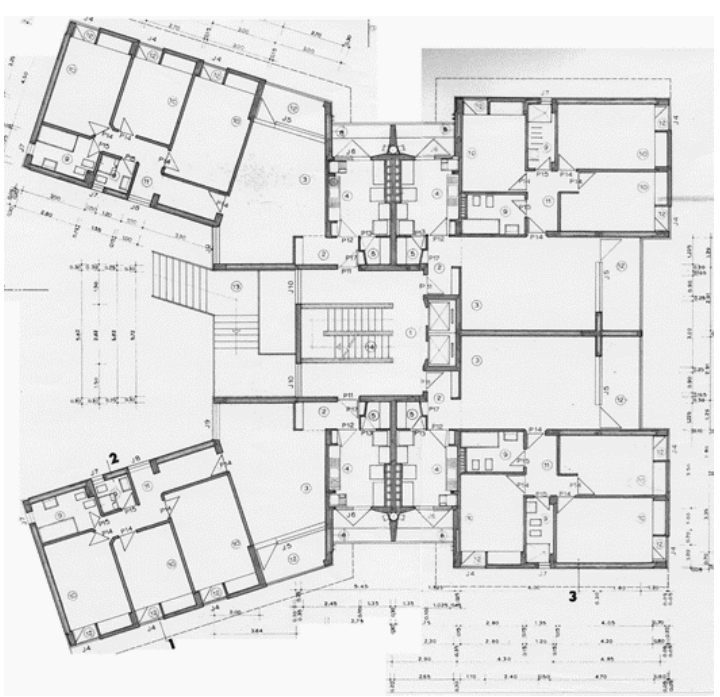
Figure 16. Plan of the apartments and the main entrance.